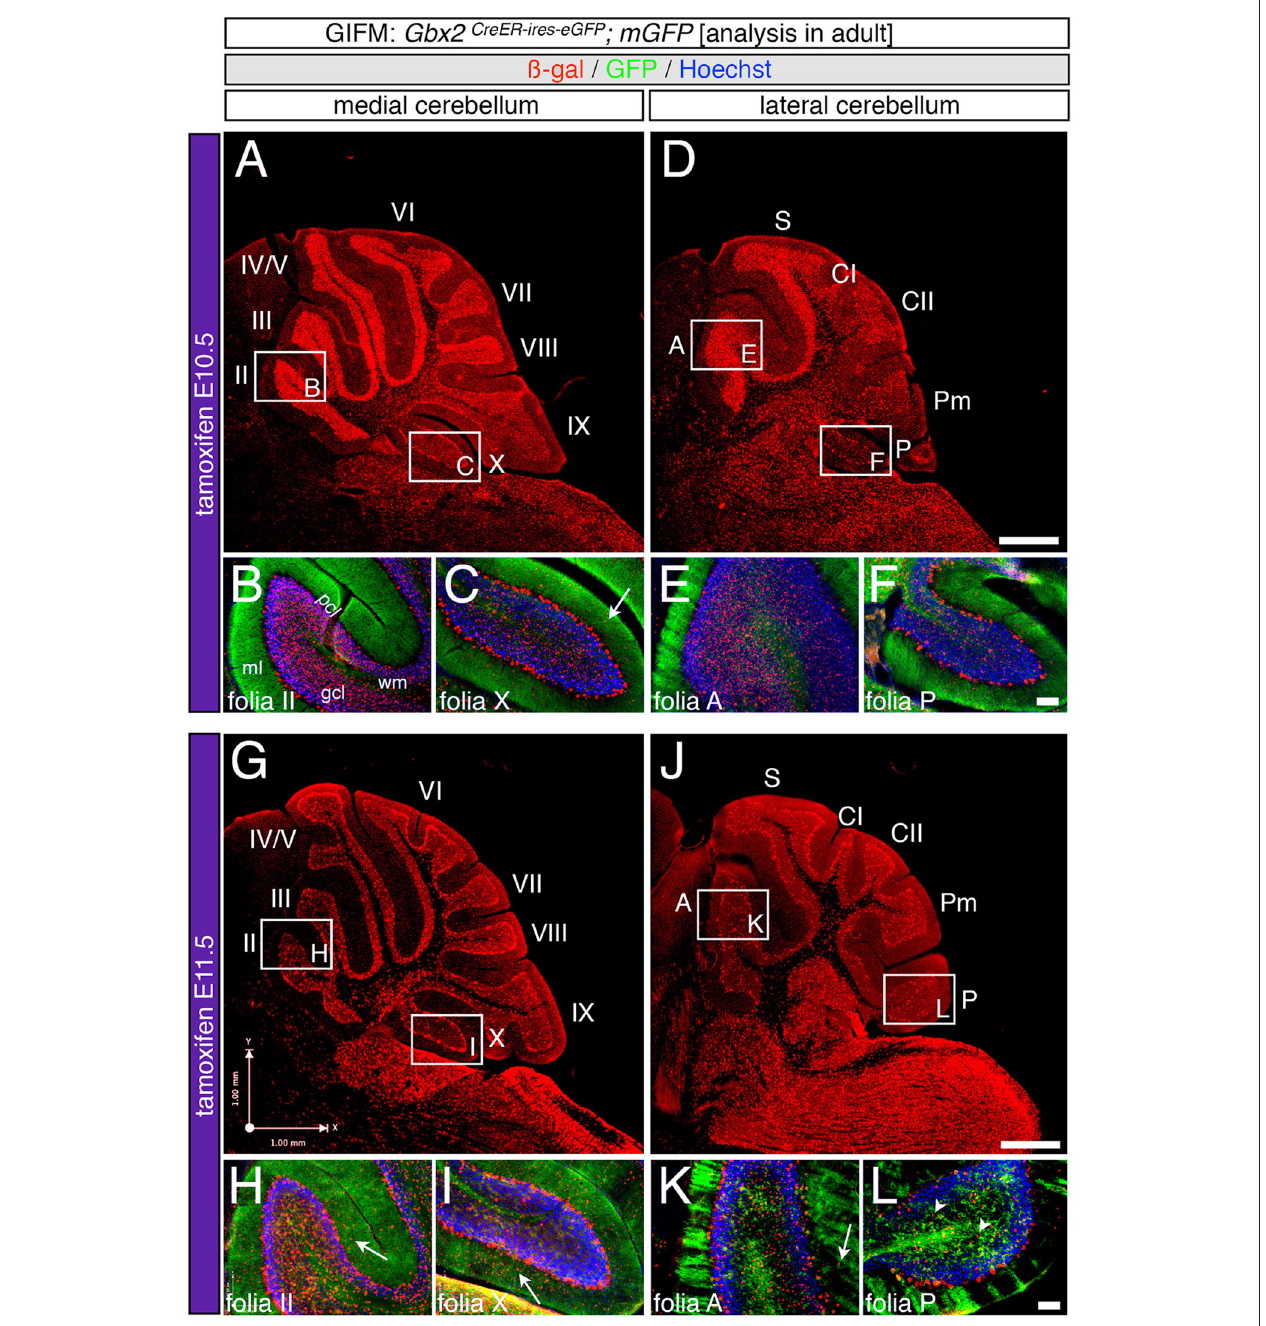
FIGURE 5 | Precursors expressing Gbx2 late give rise to few granule cells and Purkinje neurons in the adult Cb. ICC on adult sections with antibodies that label ß-gal (red) and GFP (green). (A–F) Gbx2 expressing progenitors continued to produce granule cells with marking at E10.5. However, a significant decrease in granule cell labeling in the posterior Cb created an anterior bias at this marking stage (B,C,E,F) . Gbx2 -derived Purkinje cells were also observed with marking at E10.5 and preferentially populated the posterior vermis (C) . (G–L) The Gbx2 lineage persisted in giving rise to granule cells with marking at E11.5. However, this late contribution was significantly reduced compared to earlier marking stages and continued to be biased toward the anterior Cb (H,I,K,L) . Gbx2 -derived Purkinje cells were still observed by marking at E11.5 and continued to be predominately located in the posterior vermis (I) . White arrows demarcate Gbx2 -derived nuclei in the molecular layer and arrowheads indicate “intermediate cells” in the granule cell layer and white matter. Scale bars: 180 µ m (A,D,G,J) , 90 µ m (B,C,E,F,H,I,K,L) . See Supplemental Figure 2 for fate mapping summary of Gbx2 lineage contribution to granule cells when marked late.